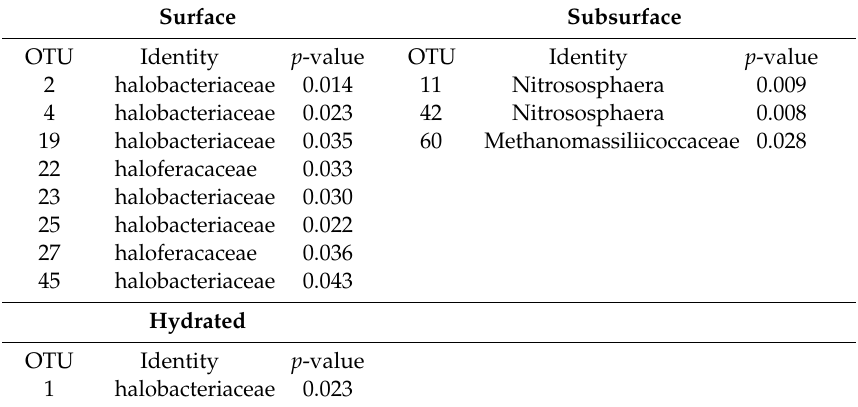
Table 4. Archaeal taxa that were significantly more abundant in 16S rRNA sequence data from saltpan wetland sediments in either a desiccated or hydrated state, or in the surface or 30 cm deep subsurface. Only those OTUs which had a significant p -value and were identified at the family level are included. There were no archaeal OTUs that were significantly more correlated with the desiccated state than the hydrated